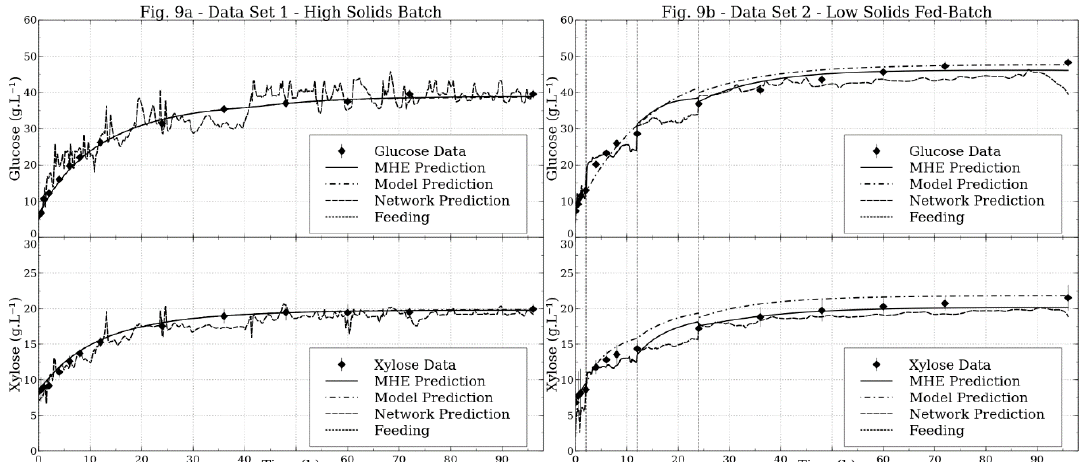
Figure 9. Fuzzy weights Moving Horizon Estimator (MHE) with 4 elements in moving window carbohydrates concentration predictions. ( a ) High Solid Batch (HSB) predictions; and, ( b ) Low Solids Fed-batch (LSB) predictions; top and bottom graphs are glucose and xylose predictions; error bars in data points are standard errors between experiment duplicates for compound concentration; vertical dotted lines are the biomass feeding times.